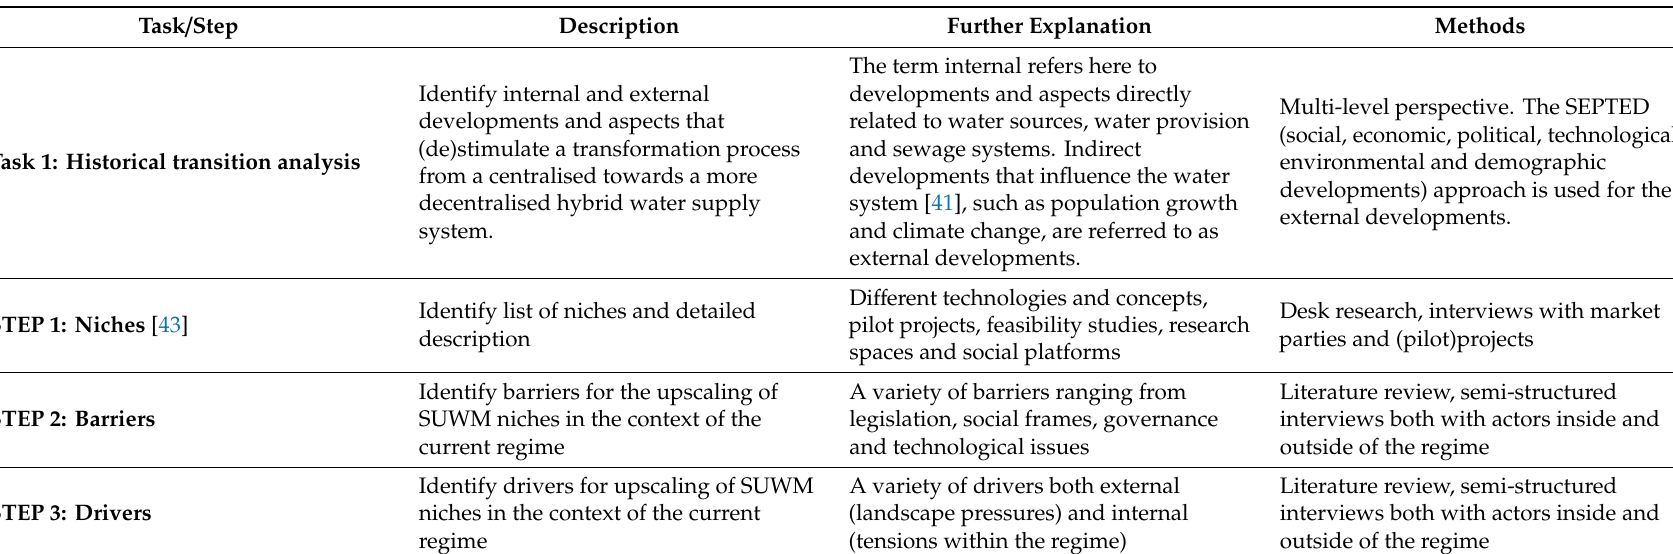
Table 1. Research approach part